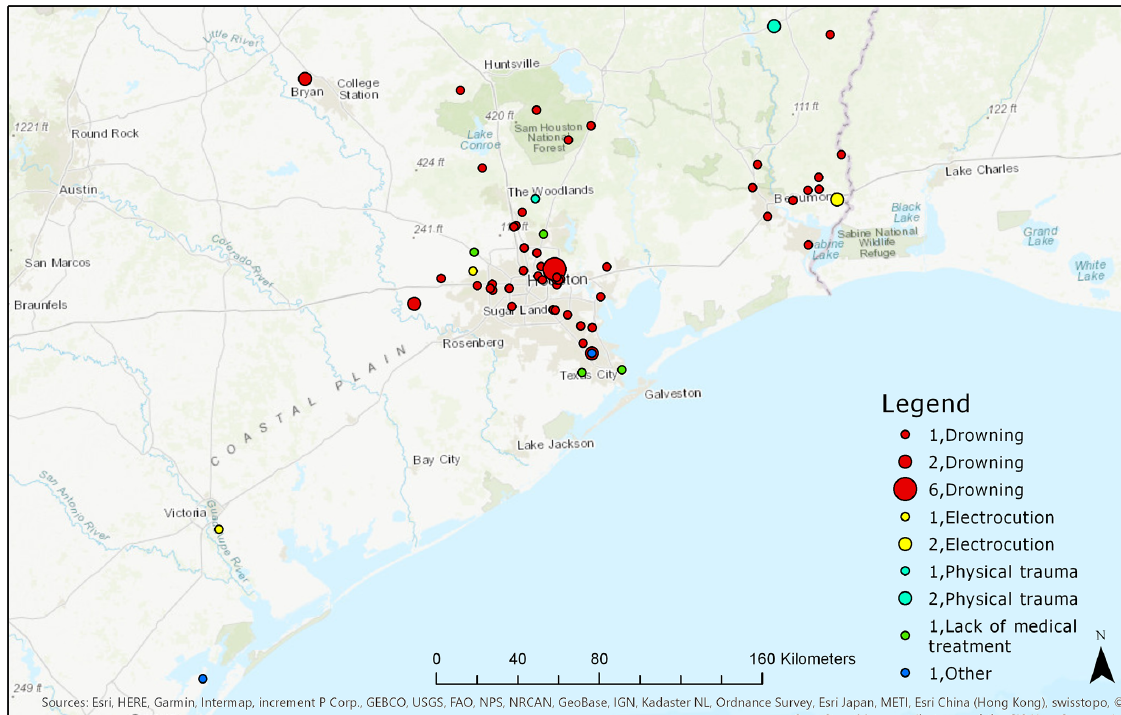
Figure 1. Locations and causes of fatalities due to Hurricane Harvey in Texas as of 8 September